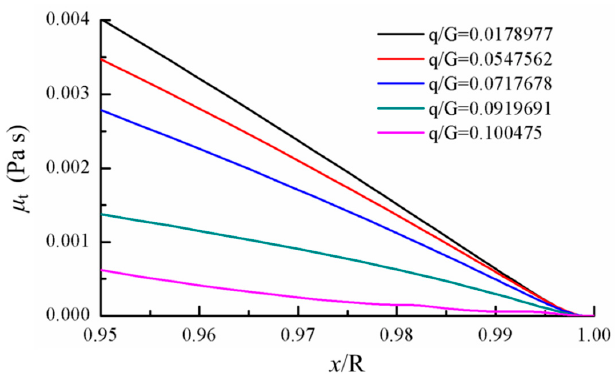
Figure 19. Distribution of the turbulent viscosity ( x/D = 26).